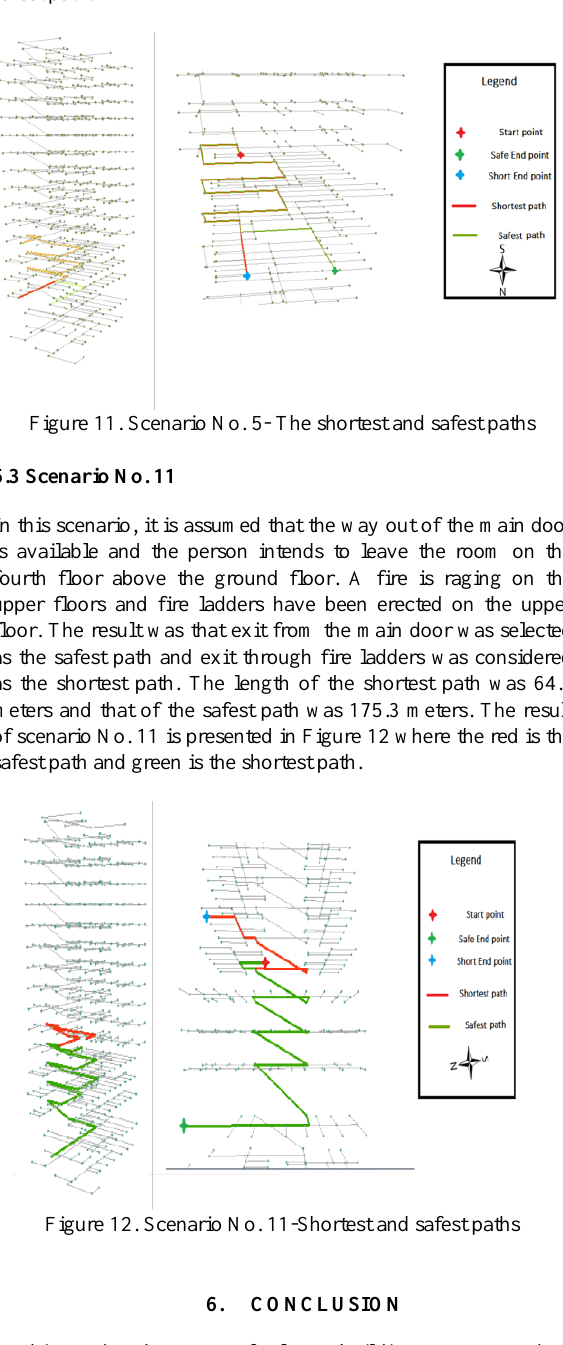
Figure 10. Scenario No. 1 representing the shortest and safest paths